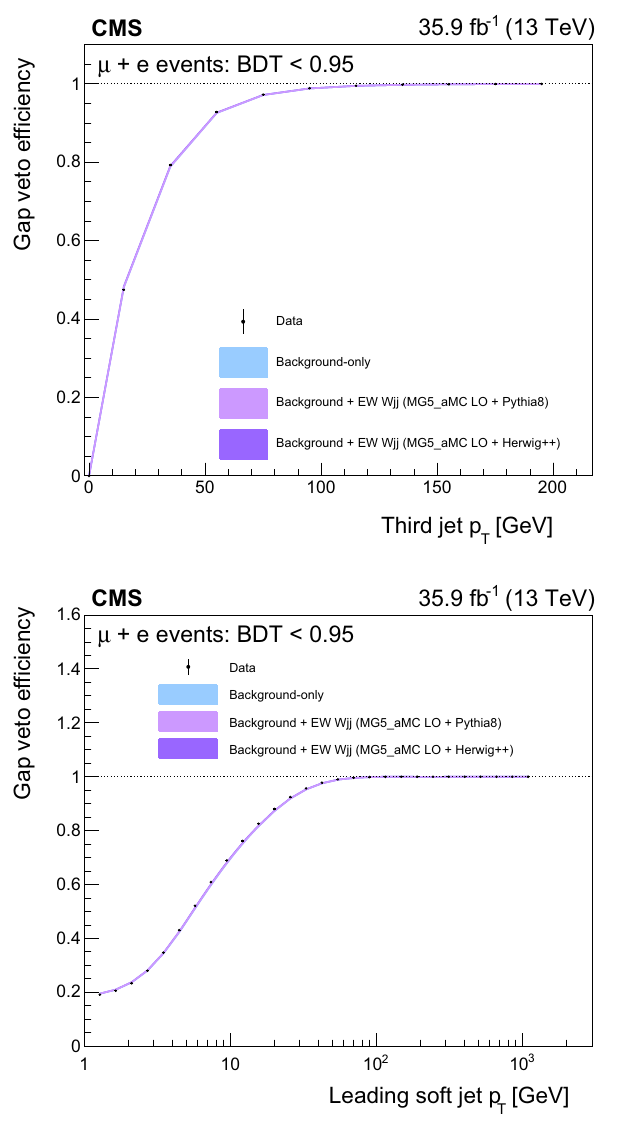
Fig. 27 Hadronic activity veto efficiencies in the signal-depleted BDT < 0 . 95 region for the muon and electron channels combined, as a func- tionoftheleadingadditionaljet p T (upperleft),additionaljet H T (upper right), leading soft-activity jet p T (lower left), and soft-activity jet H T (lower right). The data are compared with the background-only predic-